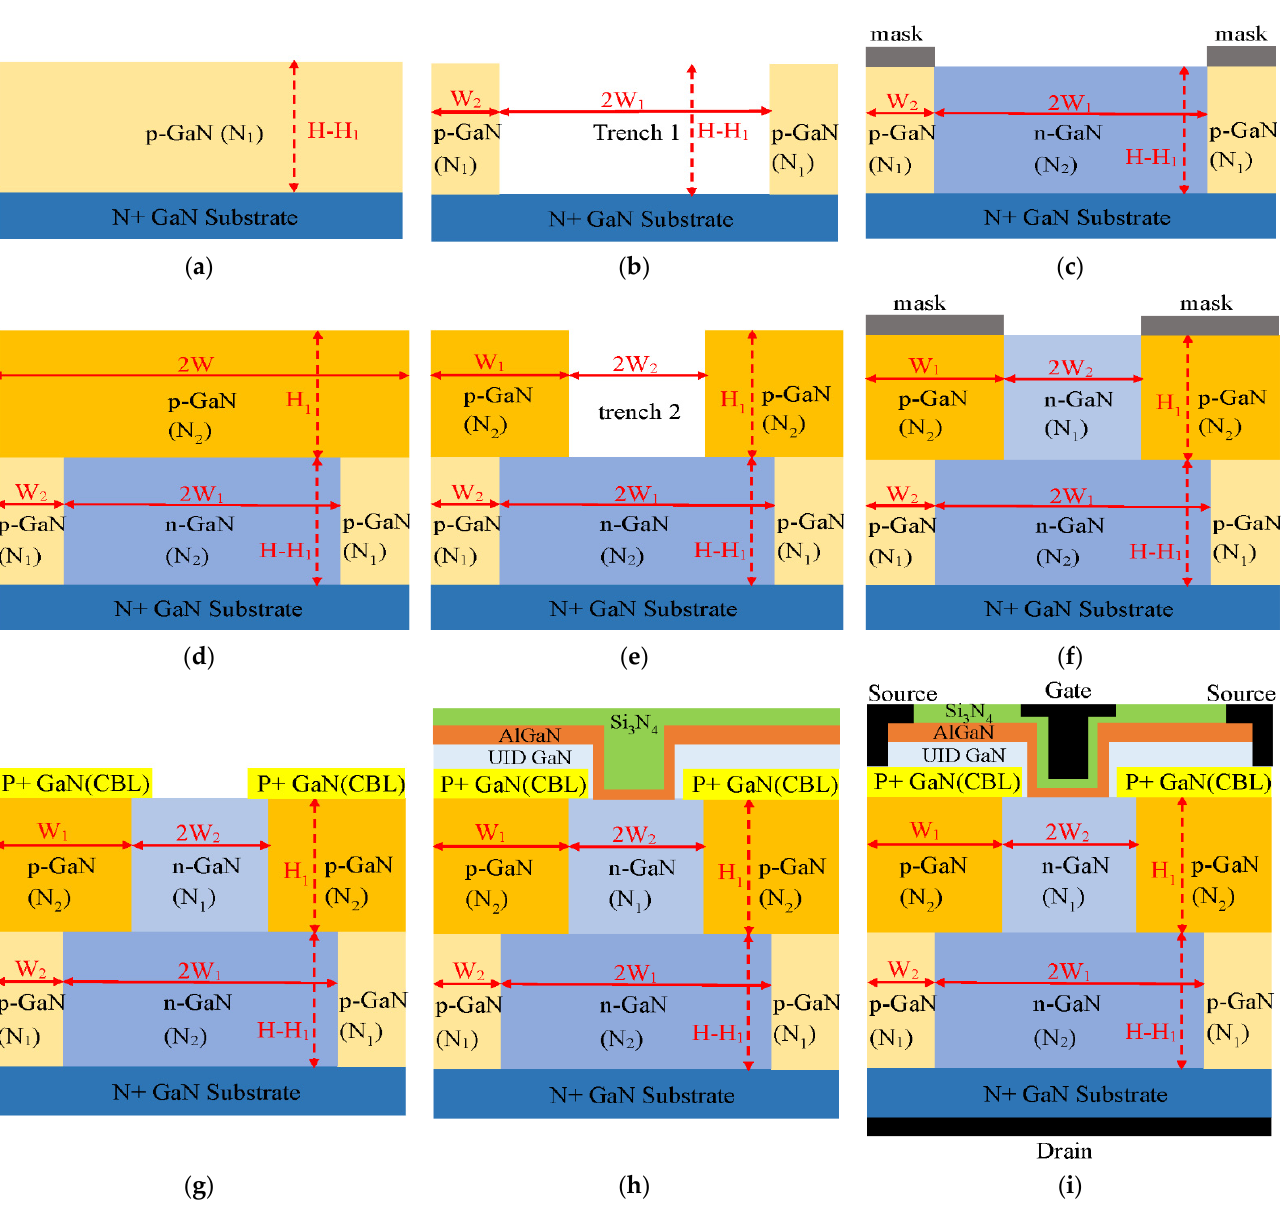
Figure 11. A feasible process to realize the proposed SDS-Trench CAVET, showing ( a ) bottom-p- GaN-layer growth, ( b ) trench 1 etching, ( c ) bottom-n-GaN-layer regrowth in trench 1, ( d ) top-p-GaN-layer growth, ( e ) trench 2 etching, ( f ) top-n-GaN-layer regrowth in trench 2, ( g ) CBL-layer growth and etching, ( h ) UID-GaN/AlGaN/Si 3 N 4 triple-trench-layer regrowth and ( i ) selective etching to form electrode and complete fabrication.